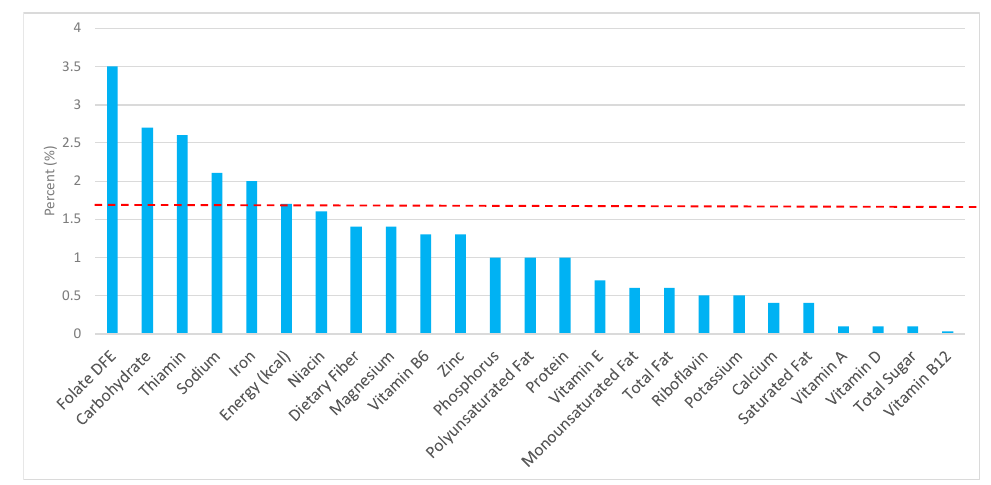
Figure 7. Cooked cereals as sources of energy and nutrients using NHANES 2009–2012, for adult males. Data are for adult males aged ≥ 19 years of age ( n = 5348), Day 1 intakes; dashed red line represents the percentage of energy provided and nutrients that surpass energy (kcal) contribution. Thus, nutrients above the dashed red line show the food category provides a greater percentage in the diet to showcase meaningful nutrient density in the diet per day.